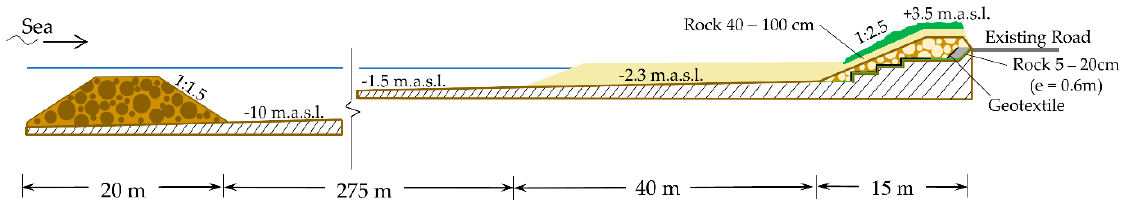
Figure 11. Alternative measure—artificially constructed dune and breakwater.